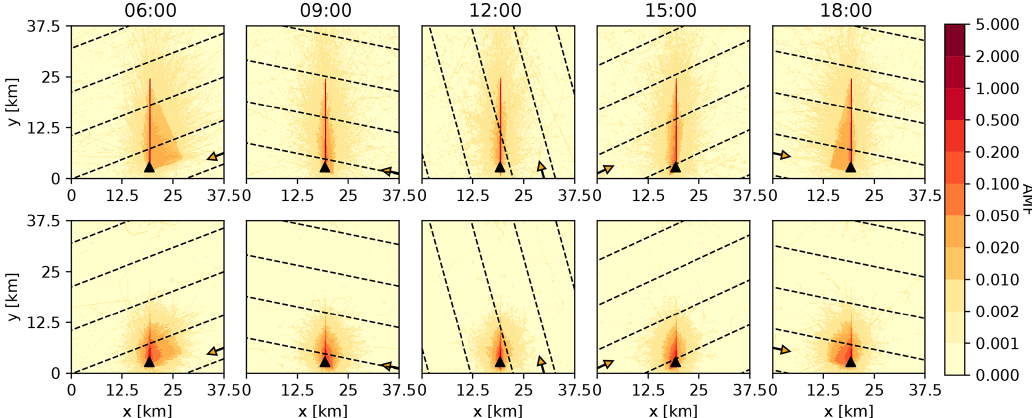
Figure 6. Top: vertically integrated 3D-box AMFs in the PBL ( z < 2 . 0km) for an instrument at the ground pointing northwards with an instrument zenith angle of 5 ◦ for different times of the day on the 21st of June in Zurich. Solar zenith angles are 77.4, 47.5, 24.6, 38.6 and 68.5 ◦ , and solar azimuth angles are 249.0, 281.5, 344.7, 65.2 and 101.7 ◦ . The arrows point away from the sun, and the dashed lines show the direction of photons coming from the sun. AMFs were simulated with a rural-type aerosol representative of spring–summer conditions in the aerosol layer (0–2km) with a visibility of 50km and a background aerosol above 2km. Bottom: same as above but for a scenario with increased aerosol (visibility of